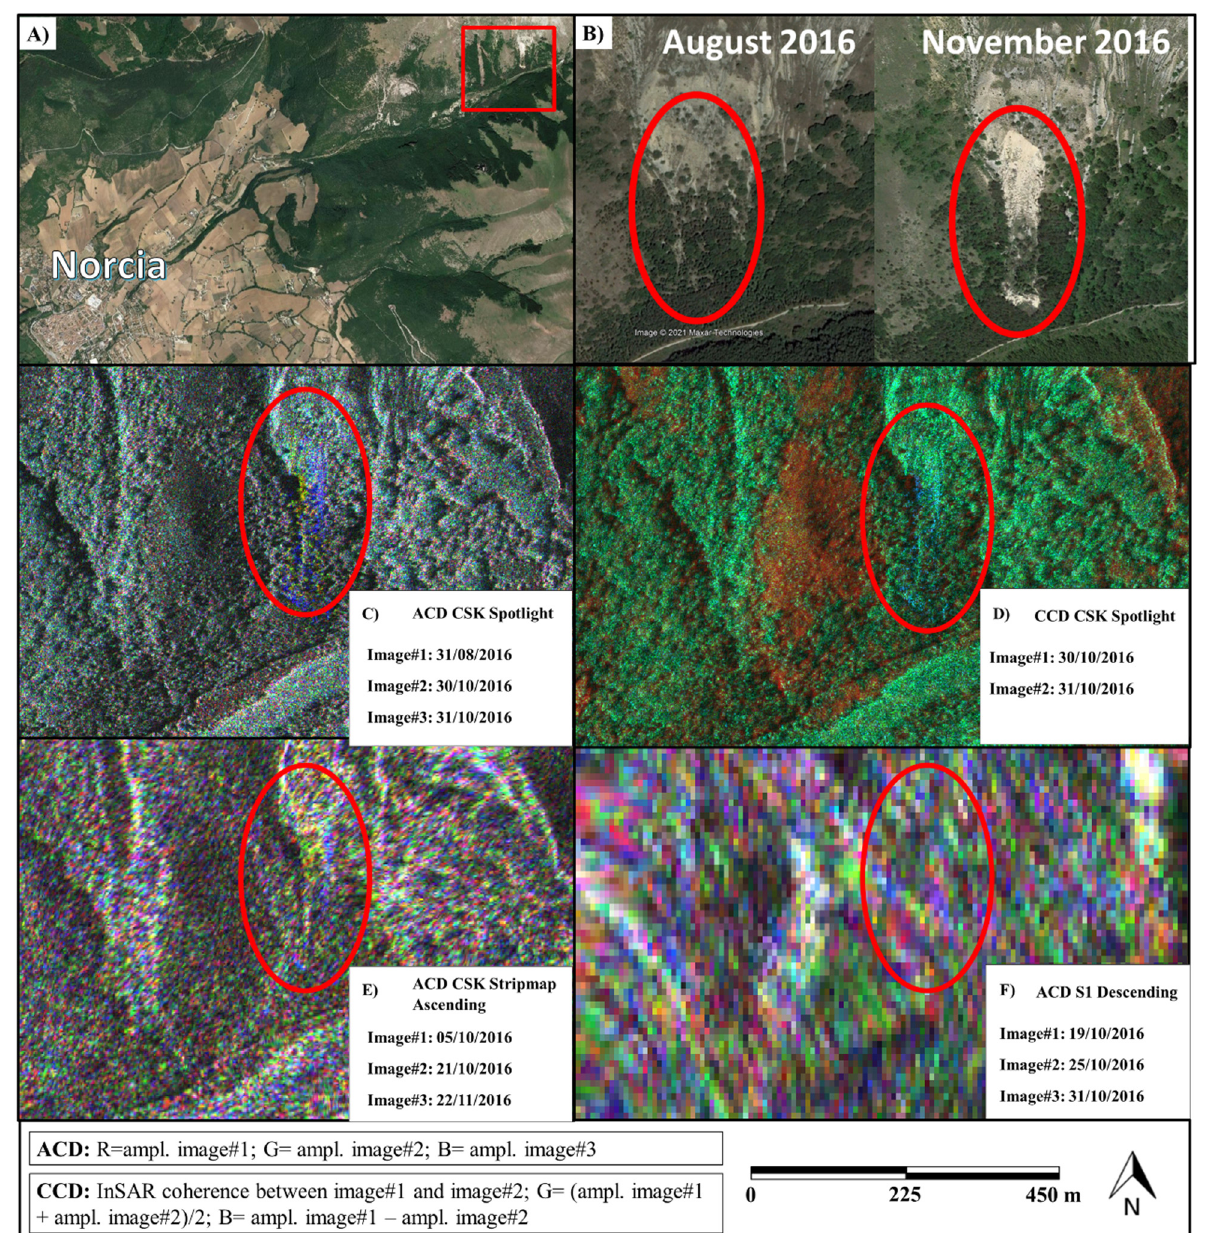
Figure 8. Extracts of EQtL in the northeastern sector of Norcia (red ellipses). ( A , B ) show the locations and pre/post-earthquake pictures of the landslide; ( C ) ACD Spotlight COSMO-SkyMed results; ( D ) CCD Spotlight COSMO-SkyMed results; ( E ) ACD StripMap COSMO-SkyMed descending results; and ( F ) ACD IW Sentinel-1 descending results.